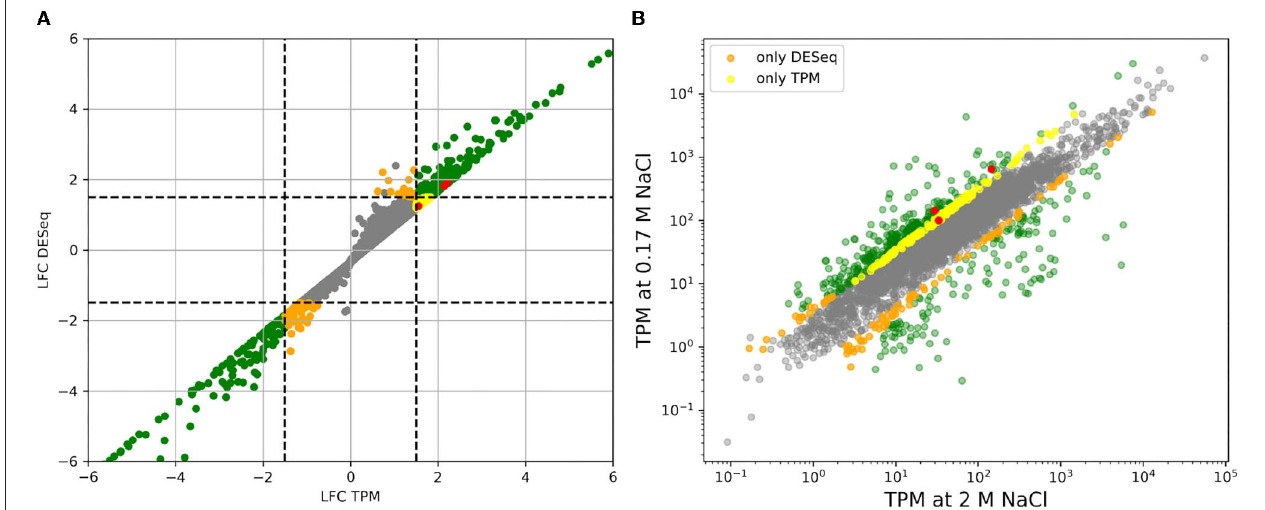
FIGURE 1 | (A) Comparison of log2-fold-changes (LFC) between low salt (0.17 M NaCl) and high salt (2 M NaCl) obtained using TPM count vs. DESeq. Dashed lines mark the threshold for differential expression. (B) Comparison of TPM counts between high and low salt. Genes that are considered to be differentially expressed by both methods are plotted in green. Only by DESeq in orange and only by TPM count in yellow. The three genes for PHB synthesis have been taking as a reference and marked in red since accumulation of PHB granules is clearly higher in cells growing at low salt compared to those growing at high salt. See below.